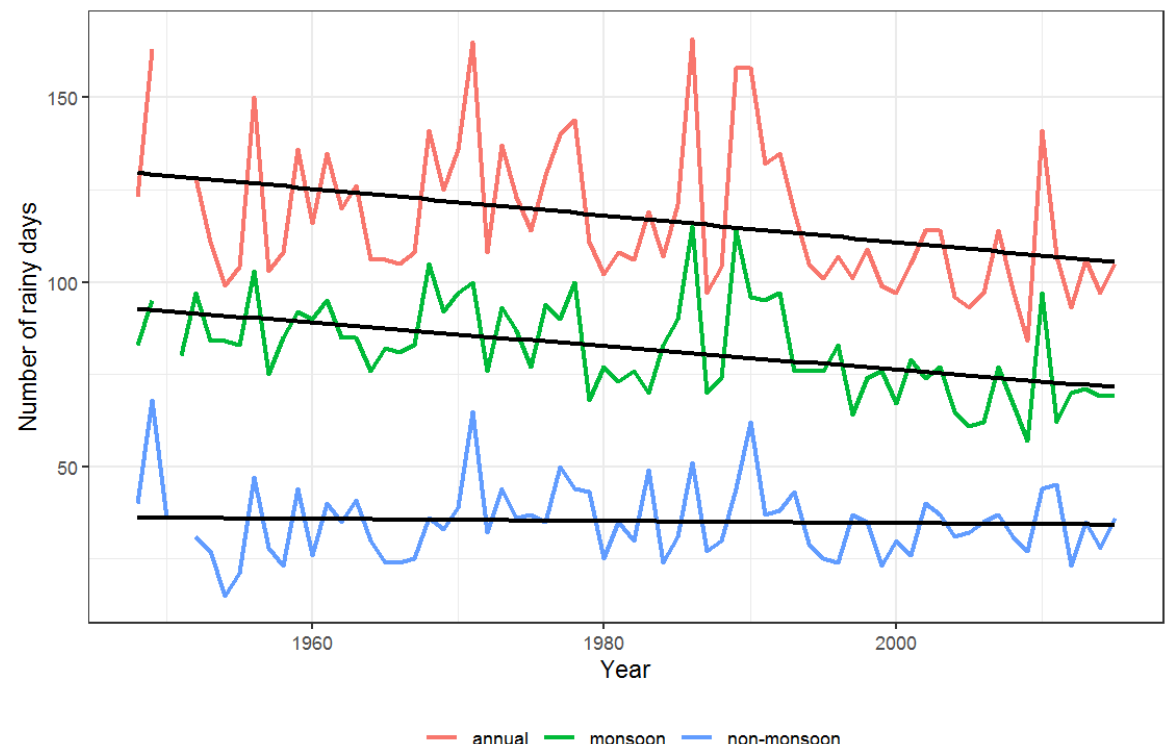
Figure 6. Trends in the number of rainy days (1948 to 2015) in the study area.